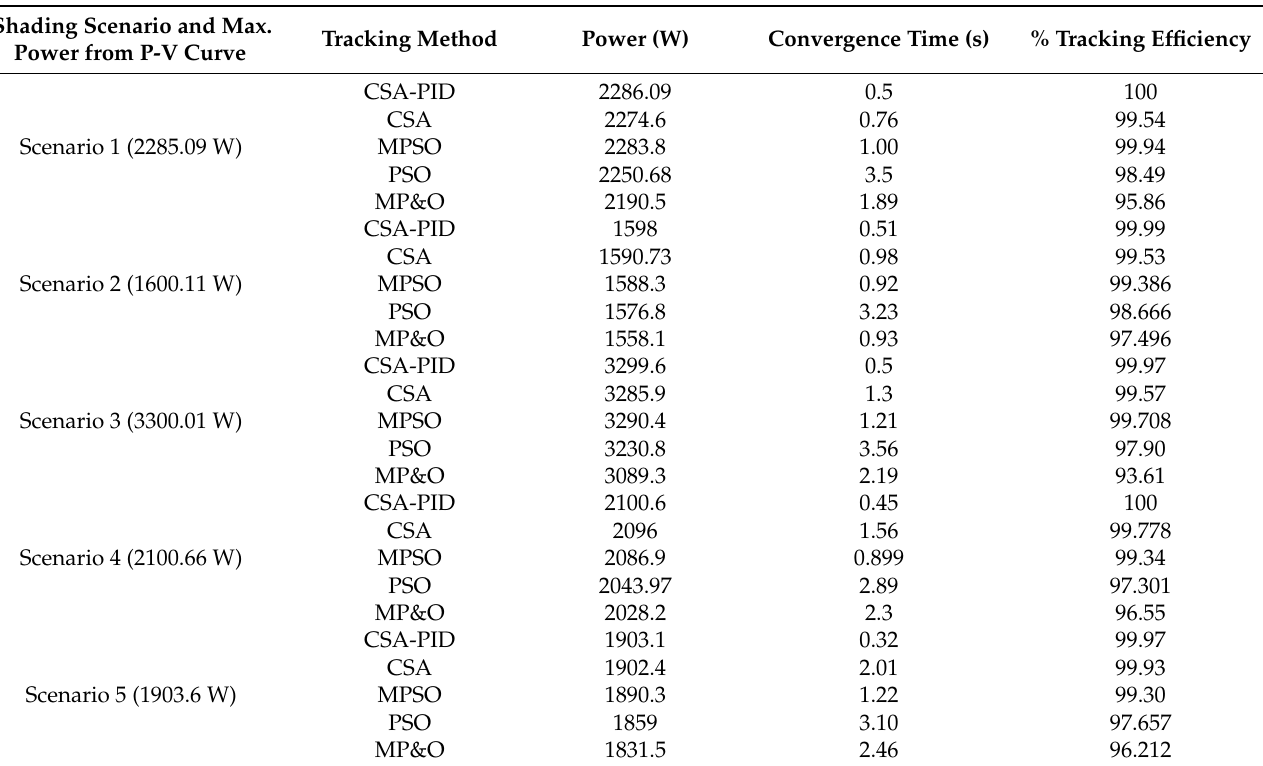
Table 7. Performance evaluation of proposed CSA-PID with other MPPT methods for UP-S250 configuration.